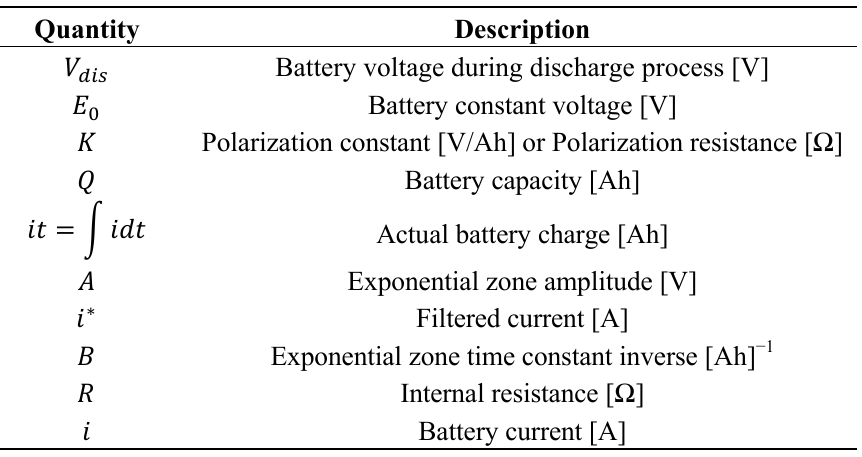
Table 1. Explanation of the quantities of Equation